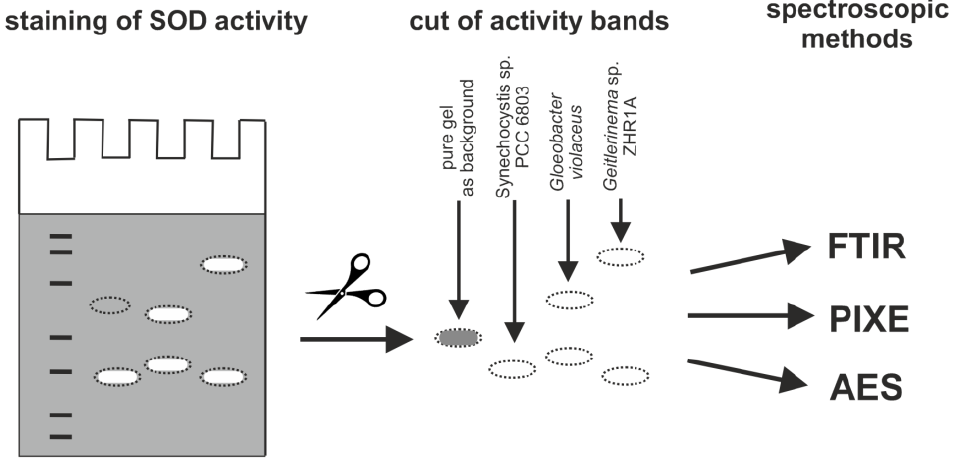
Figure 5. The scheme of preparation of SOD activity bands in a gel for spectroscopic analysis: Fourier transformed infrared (FTIR) spectroscopy, particle-induced X-ray emission (PIXE), atomic emission spectroscopy (AES). For the spectroscopic analyses, a pure gel without SOD activity was used as background.